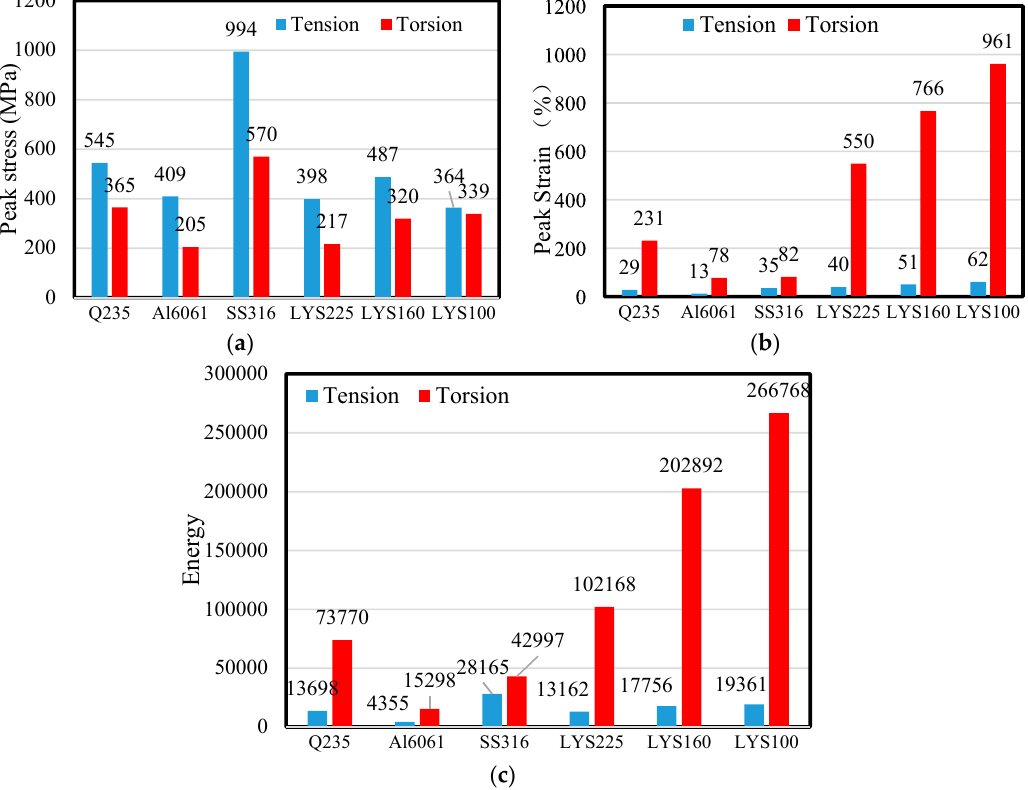
Figure 5. Comparison of basic properties of materials. ( a ) Peak stress comparison; ( b ) Ultimate strain comparison; and ( c ) Energy absorption comparison.